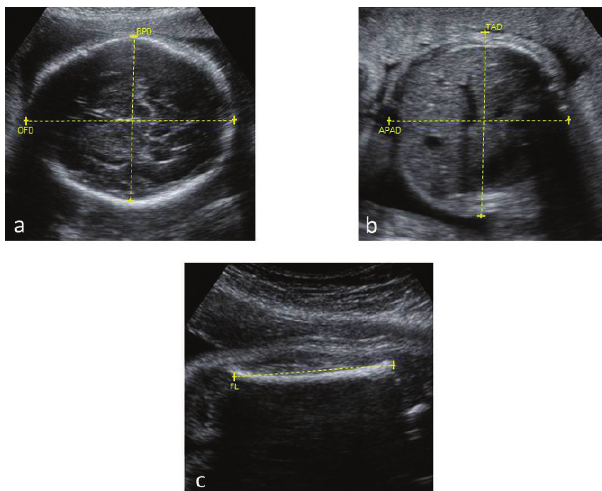
Figure 1 - Ultrasound images demonstrating the transverse section of the fetal head (A), abdomen (B) and femur length (C). Markers are placed depicting measurements of the biparietal (BPD), occipitofrontal (OFD), antero-posterior (APAD) and trans- verse abdominal (TAD) diameters and femur diaphysis